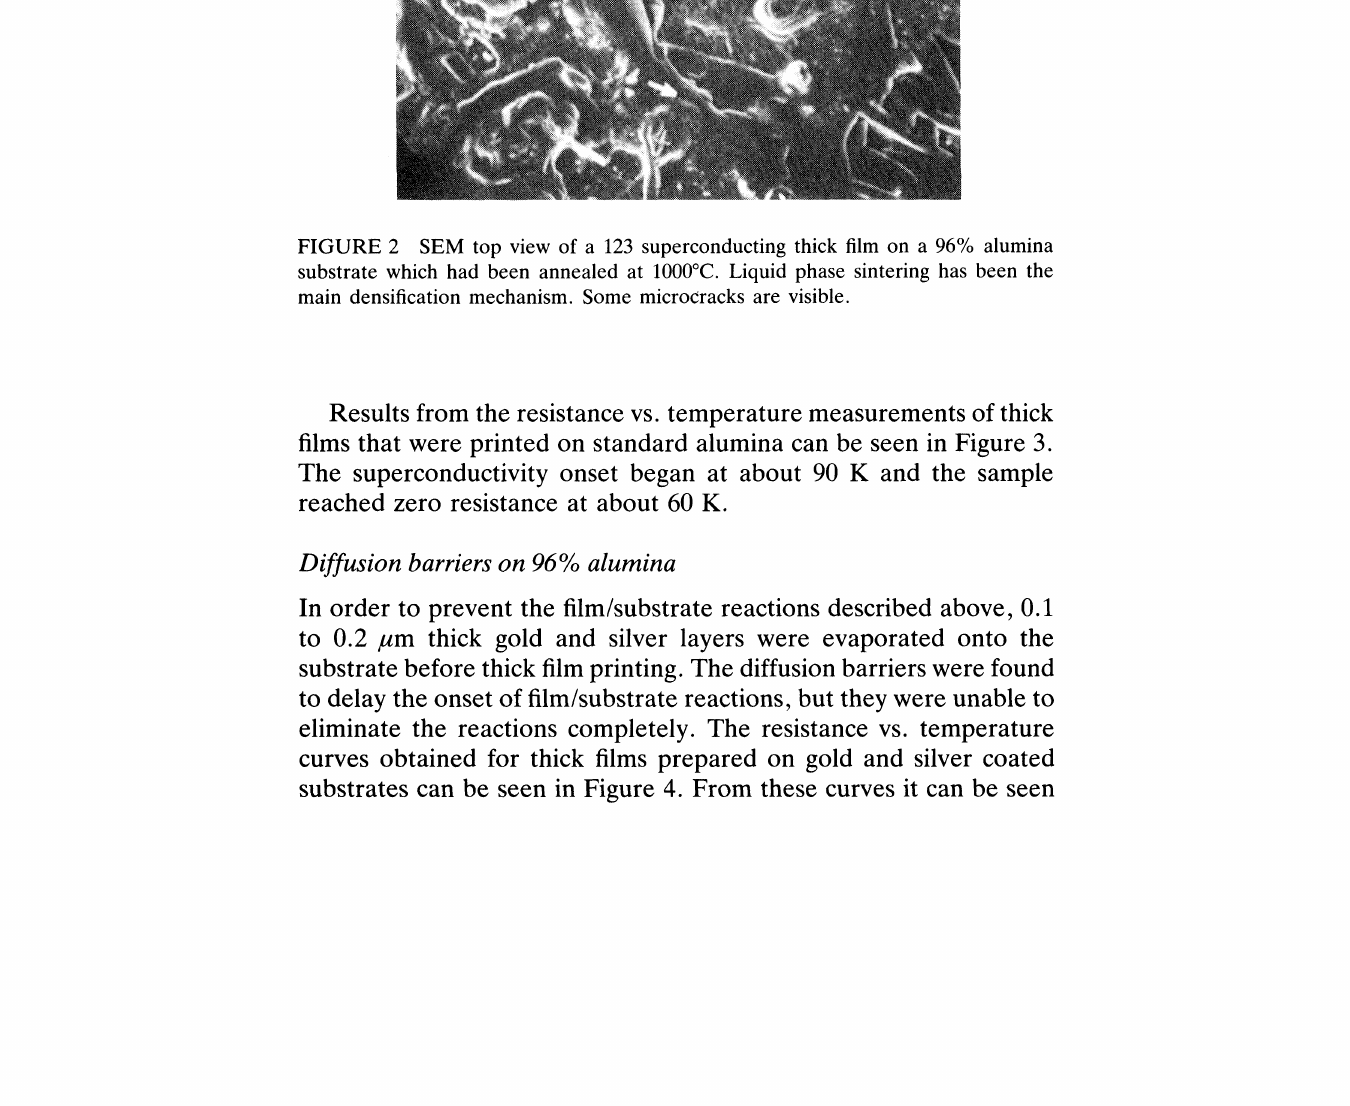
FIGURE 2 SEM top view of a 123 superconducting thick film on a 96% alumina substrate which had been annealed at 1000C. Liquid phase sintering has been the main densification mechanism. Some microcracks are